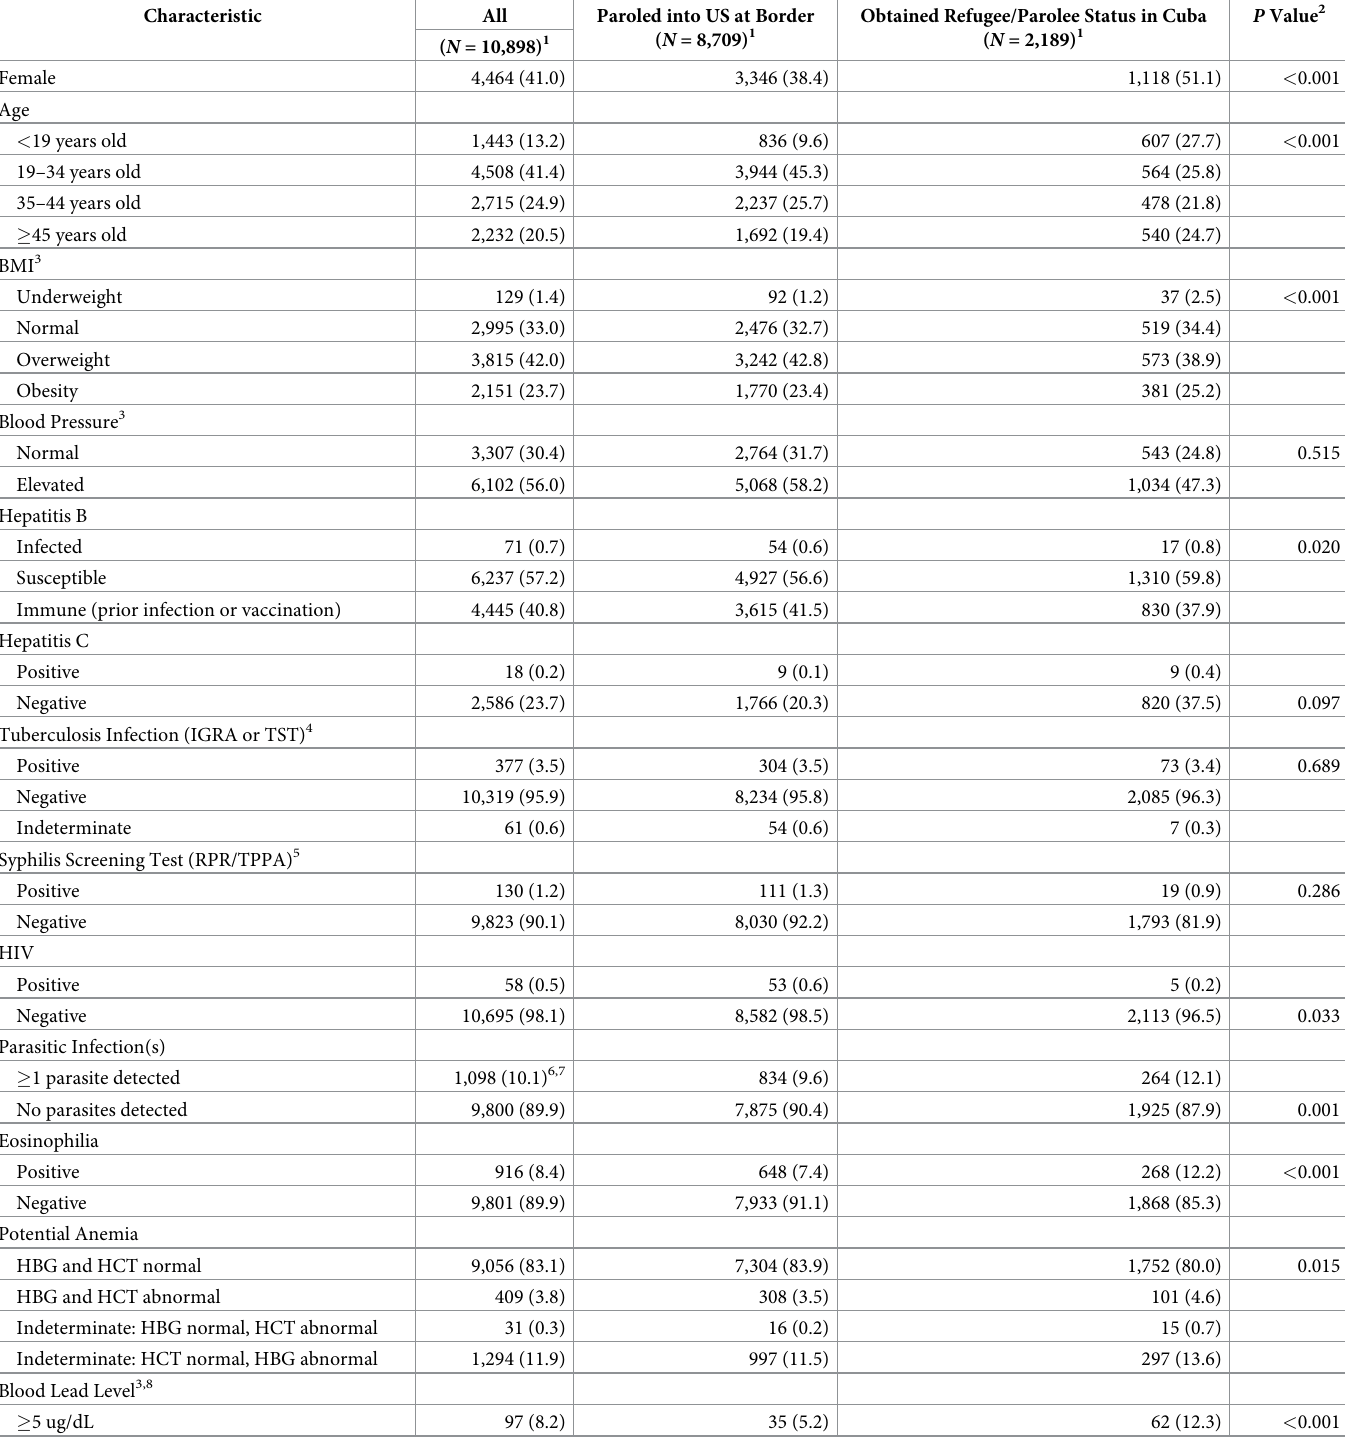
Table 2. Demographic characteristics and clinical screening results of individuals from Cuba resettling in Texas from 2010 to 2015 by route of entry ( N ,